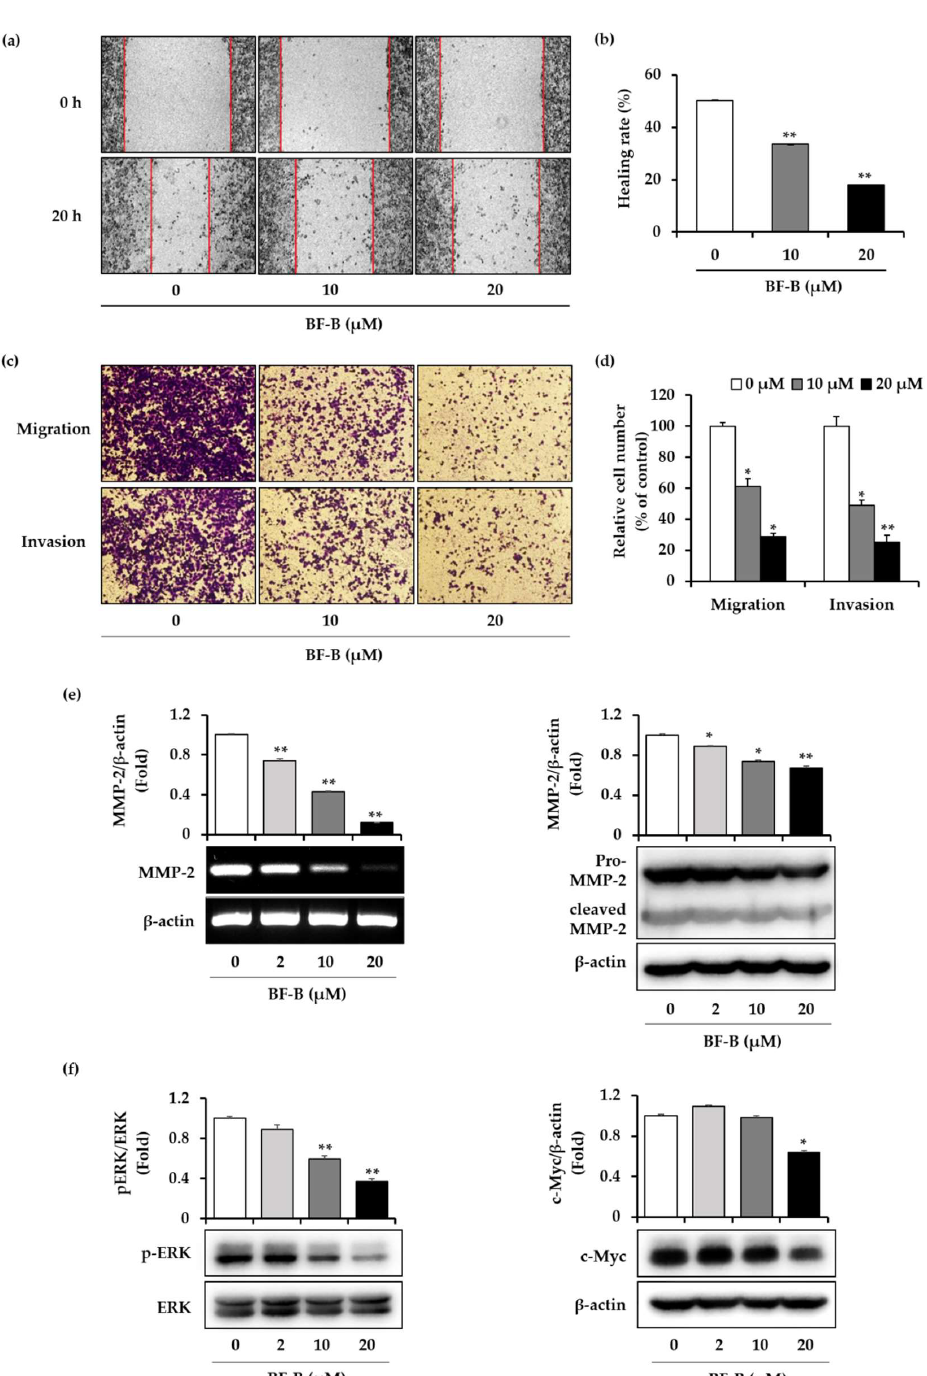
Figure 5. Effect of BF-B on migration and invasion of PANC-1 cells. ( a , b ) PANC-1 cells were treated with BF-B at the indicated concentrations for 20 h, and then subjected to wound healing migration assay. The wound distance was measured at 0 and 20 h to calculate healing rate as explained in methods. ** p < 0.001 as compared to control. ( c , d ) Cells were treated with BF-B at the indicated concentrations for 20 h, and then subjected to transwell migration and invasion assay. Transmigrated and invaded cells were counted from the five photographed fields in each group. * p < 0.01 and ** p < 0.001 as compared to control. ( e , f ) PANC-1 cells were treated with BF-B at the indicated concentrations for 20 h. The level of MMP-2 mRNA was evaluated by real-time PCR and level of MMP-2, phospho ERK 1 / 2 , ERK 1 / 2 , and c-Myc were detected by Western blotting. Images are representative of three independent experiments with similar results. * p < 0.01 and ** p < 0.001 as compared to